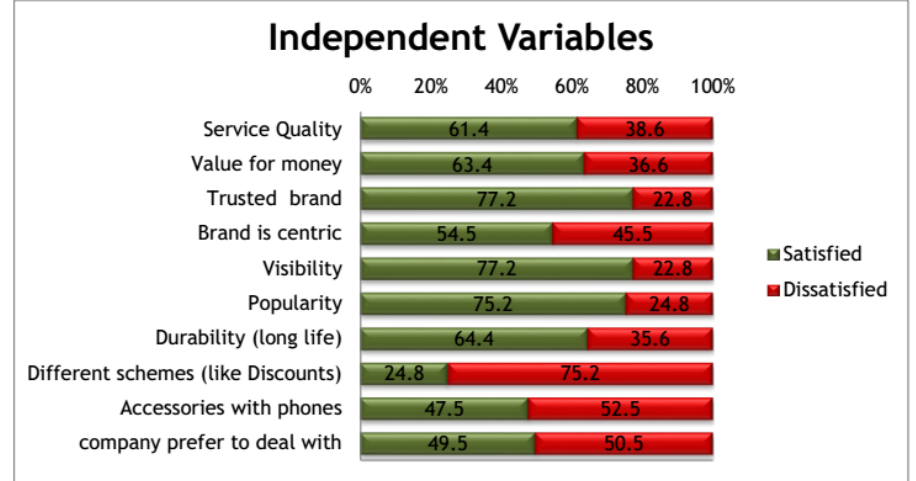
Fig. 3. Transformed information of exogenous